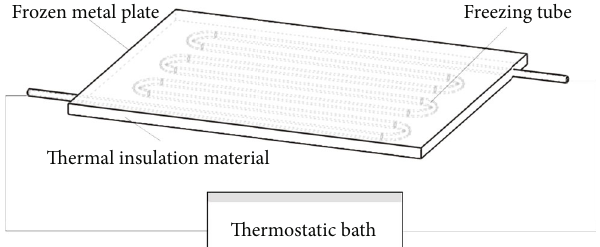
Figure 1: Schematic of the freezing